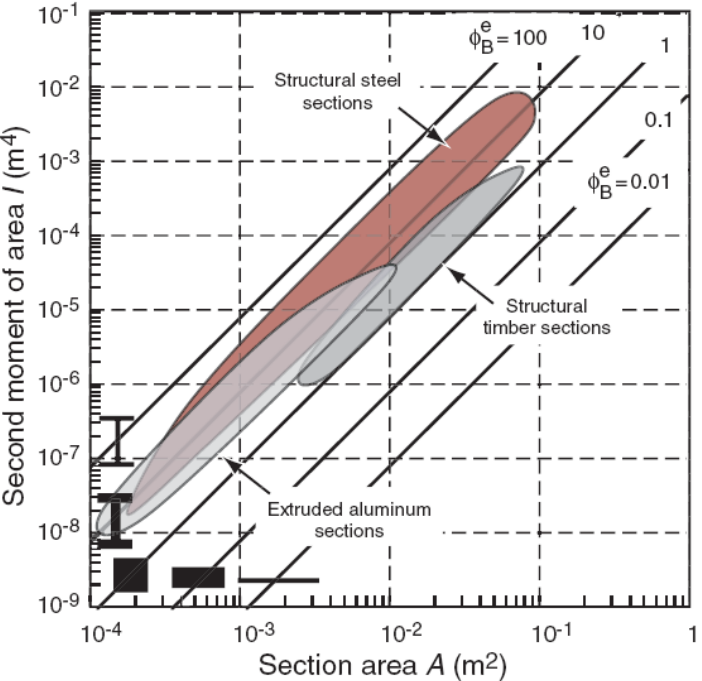
Figure 6. The second moment of area I, plotted against section area A (according to Ashby